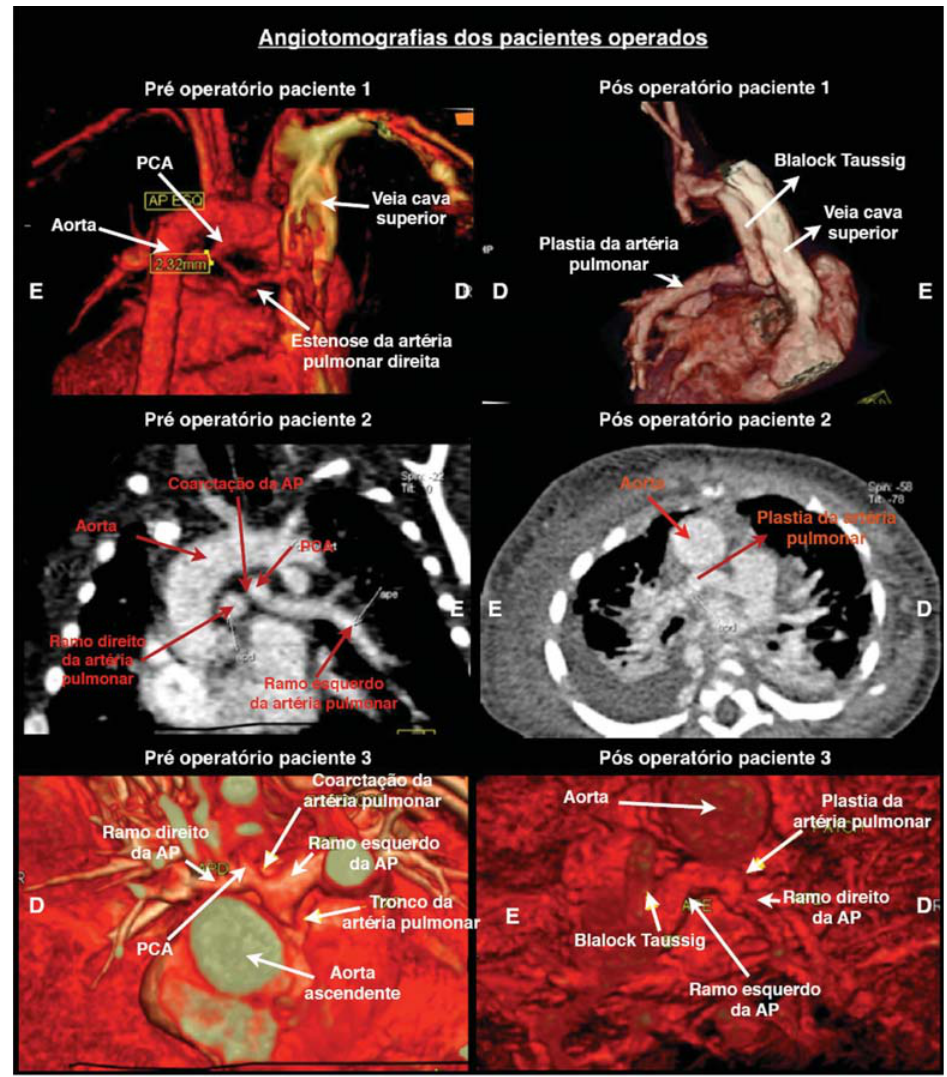
Fig. 4 - Demonstração das angiotomografias de múltiplos detectores dos pacientes submetidos à